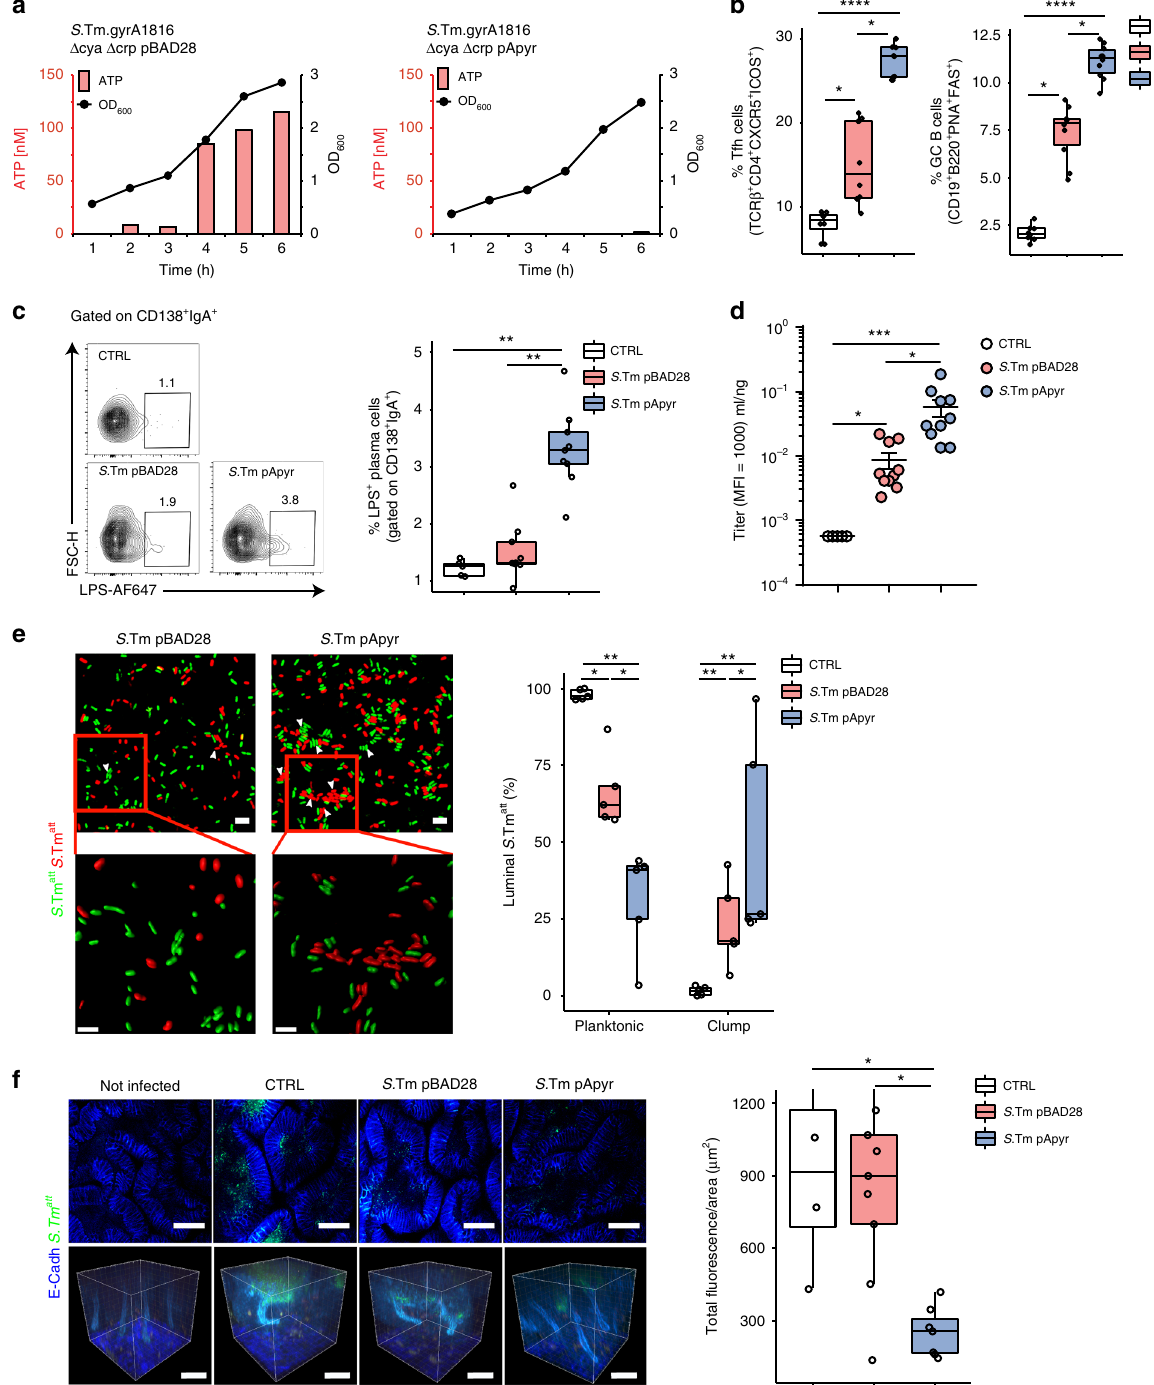
Fig. 4 Enhanced anti- Salmonella SIgA by apyrase. a ATP concentrations in culture medium (bars) and bacterial growth (OD 600 ) over time for S .Tm pBAD28 and S .Tm pApyr . b Quanti fi cation of Tfh and GC B cells and c representative contour plots with statistical analysis of plasma cells speci fi c for S .Tm LPS in PPs 48 h after orogastric infection with S .Tm WT in non-immunized mice (CTRL) and mice immunized with S .Tm pBAD28 or S .Tm pApyr . d Intestinal anti- S .Tm IgA titer in non-immunized mice (CTRL) and mice immunized with S .Tm pBAD28 or S .Tm pApyr . e Representative 2D (upper panels, scale bar: 5 µ m) and 3D (lower panels, scale bar: 5 µ m) images, and statistical analysis of bacterial clumping in live cecal content from mice vaccinated with S .Tm pBAD28 or S . Tm pApyr , 8 h after orogastric administration of a 1:1-mix of mCherry- and GFP-tagged S .Tm att (10 7 CFU). CTRL, non-vaccinated mice. f Images from two- photon confocal microscopy of caeca and 3D rendering of crypts from E-cadherin-mCFP mice 18 h after infection with 10 7 CFU of GFP-tagged S .Tm att . Infected mice were either non-vaccinated (CTRL) or vaccinated with the indicated S .Tm transformant. Graph shows the statistics of total fl uorescence inside the crypts per unit of internal area. The boxplots show median and upper and lower quartiles. The extreme lines show the highest and lowest value . The boxplot is overlaid with the visualization of single observations. Kruskal – Wallis with Dunn ’ s post-test. * p < 0.05, ** p < 0.01, *** p < 0.001, **** p < 0.0001. One representative experiment out of at least three is